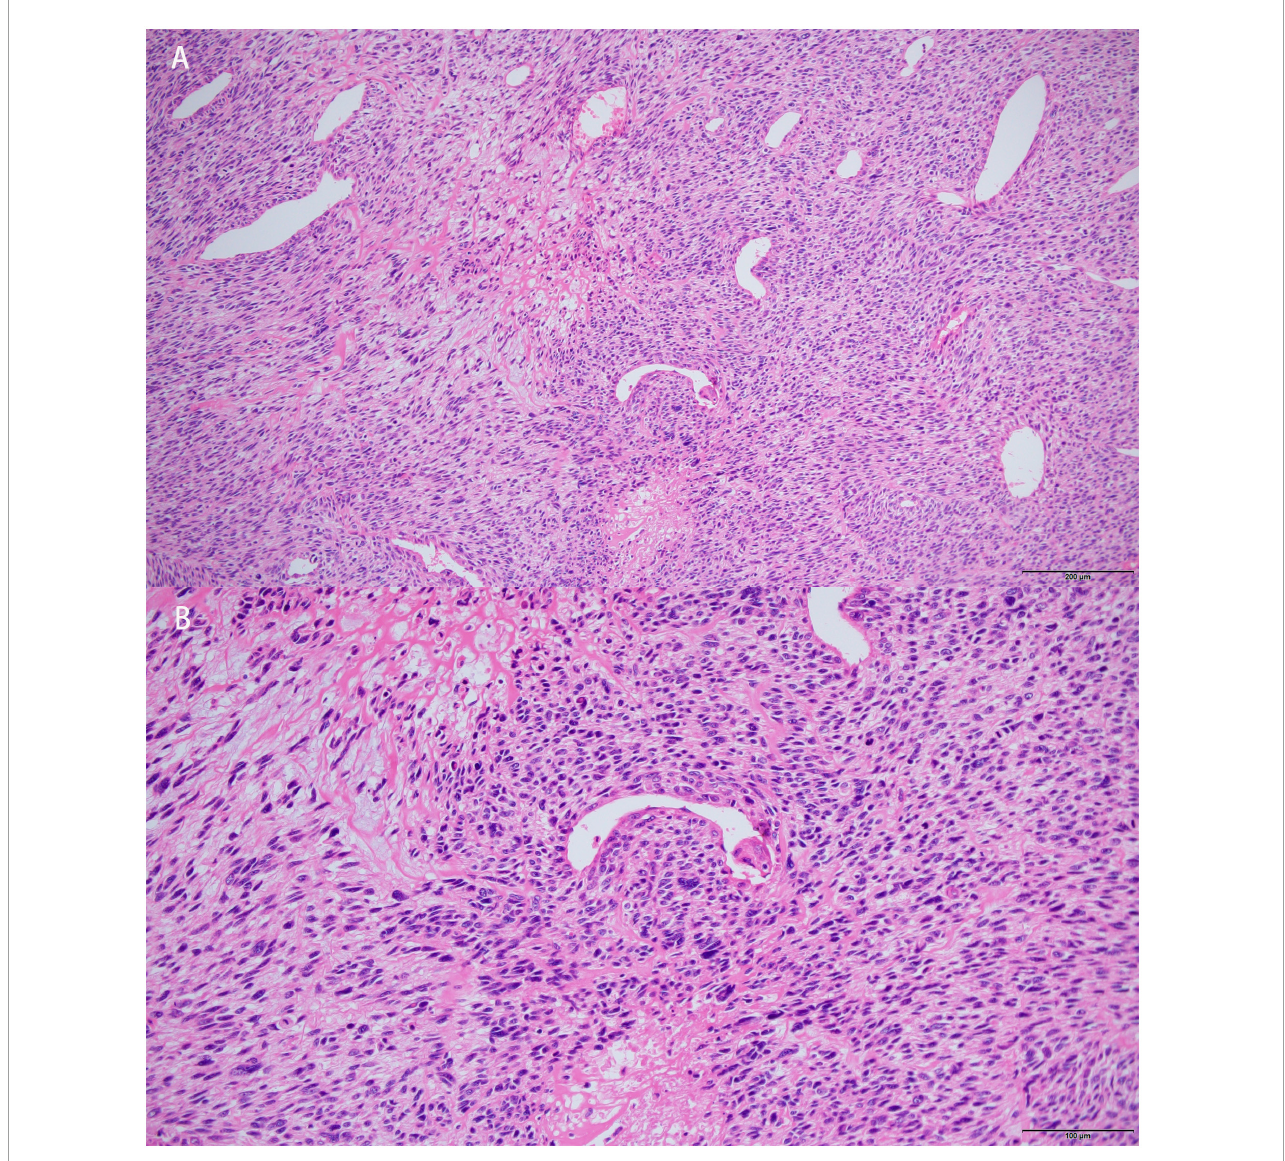
FIGURE5 Histopathological features of the left atrial mass. Hematoxylin-eosin (HE) stained section showed that tumors cells were spindle-shaped, prominent atypical. Mitotic activity was frequent. Myxoid changes could be observed in stroma. [Bars: (A) 200 µ m; (B) 100 µ m].